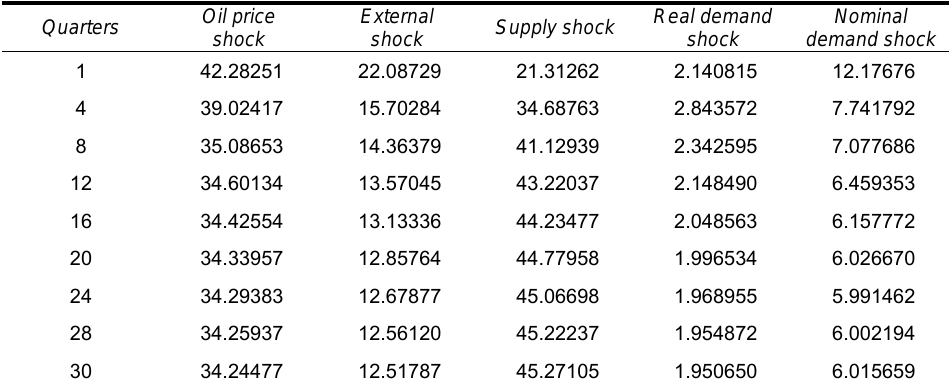
Table 4. Variance decomposition of the growth